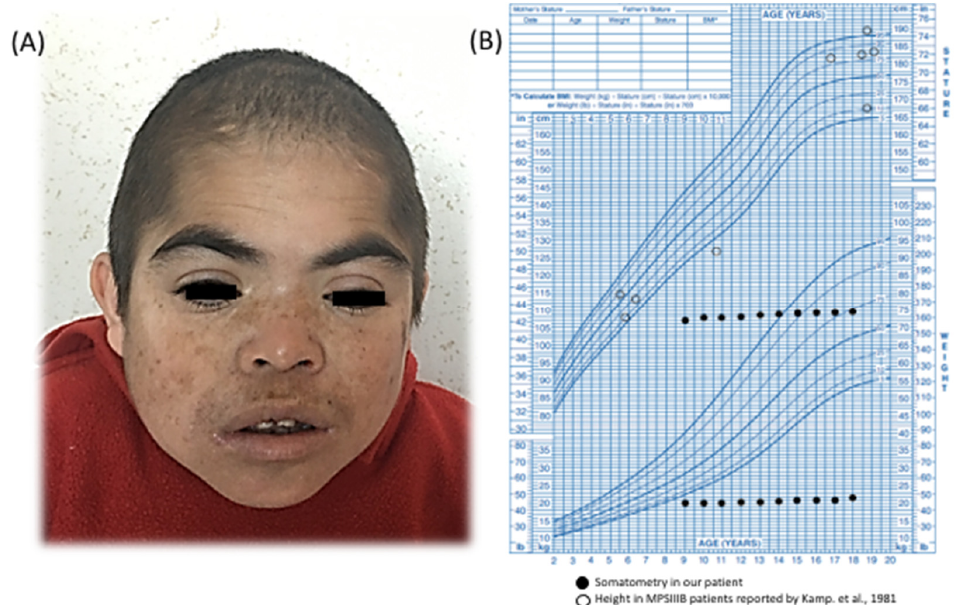
Figure 1. ( A ) Photograph of the patient at 18 years of age, showing bifrontal narrowing, thick eyebrows, left palpebral ptosis, thick lips, and a coarse face. ( B ) Weight and size chart of the general population showing the arrest of both parameters in the present patient and those previously reported by Kamp et al. [5].